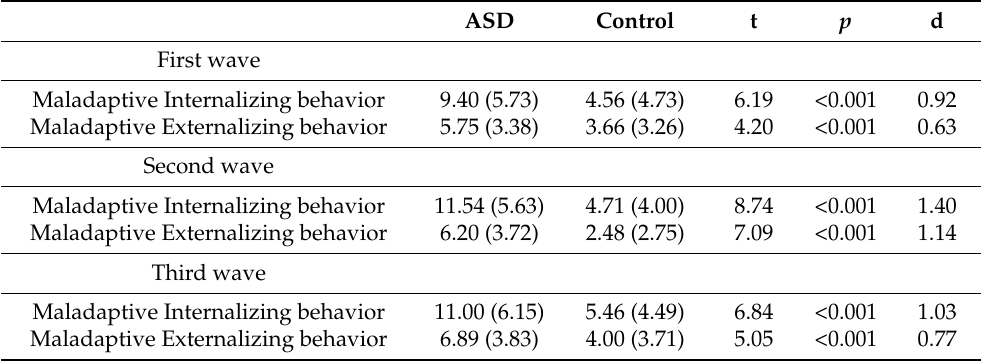
Table 4. Differences in the internalizing and externalizing maladaptive behavior of children with ASD and neurotypical children.